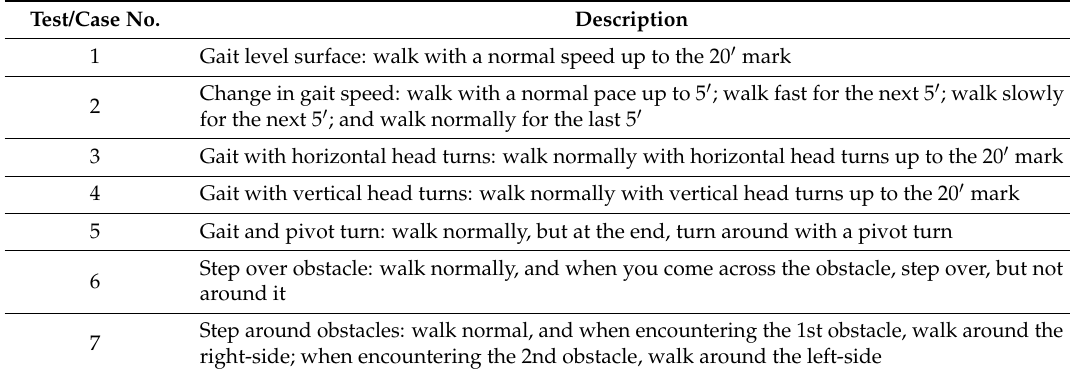
Table 1. Dynamic Gait Index (DGI) tests performed for gait analysis.